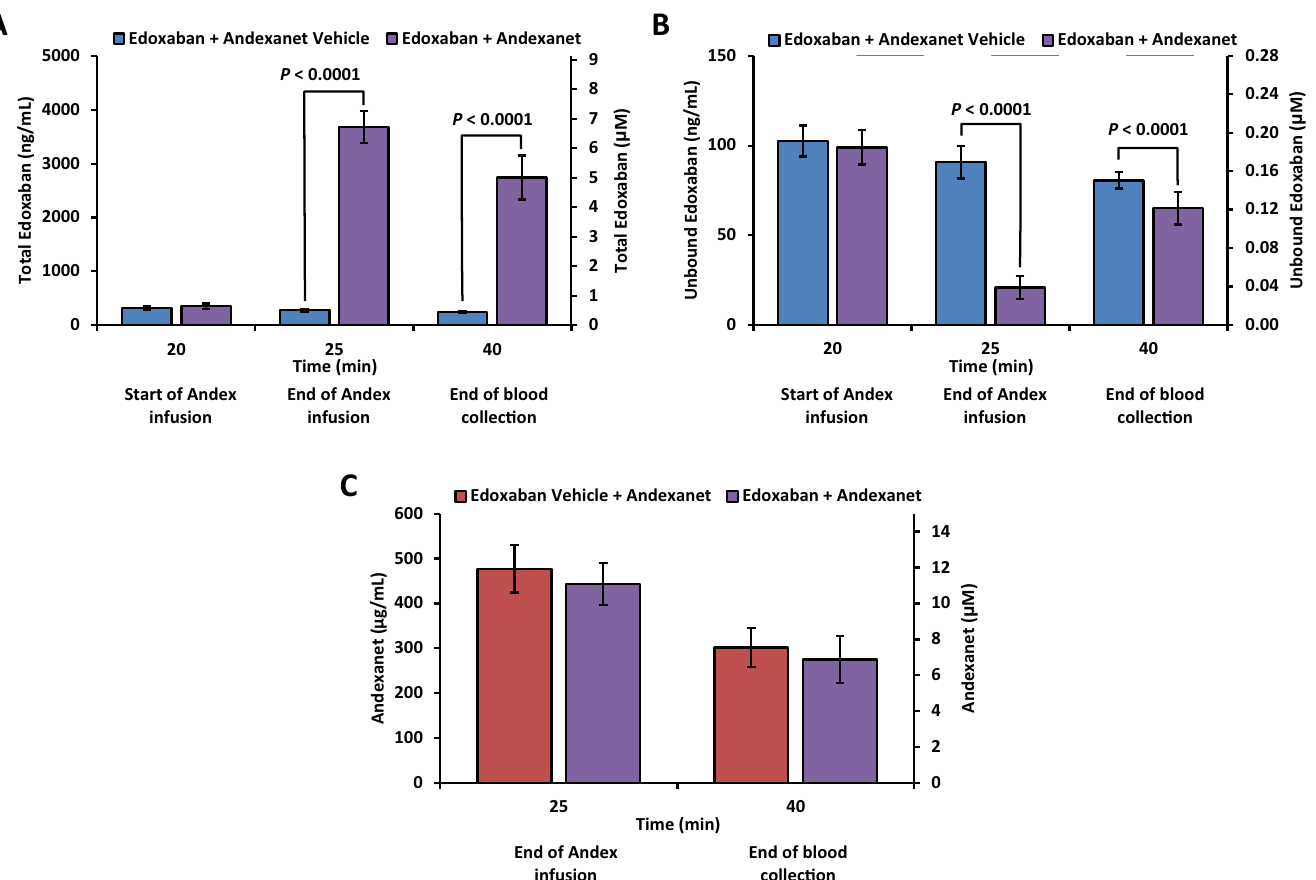
Fig 7. Change in pharmacokinetic parameters following administration of andexanet in edoxaban-anticoagulated rabbits. (A) Total edoxaban plasma concentration. (B) Unbound edoxaban plasma concentration. Total and unbound (pharmacologically active) edoxaban plasma levels were determined by LC/MS/MS with a turbo-ion spray source using an internal standard (edoxaban-D6) as described in Materials and Methods. Pharmacologically active unbound edoxaban was separated using an HTD96b apparatus at 37˚C for approximately 4 hours with gentle vortexing. (C) Andexanet plasma concentration was determined by ELISA with paired antibodies recognizing human FX/FXa. Andexanet standard was freshly prepared in blocking buffer with the same lot material used in this study for 8-point curve (0–200 ng/mL). Data are plotted as mean ± standard deviation.